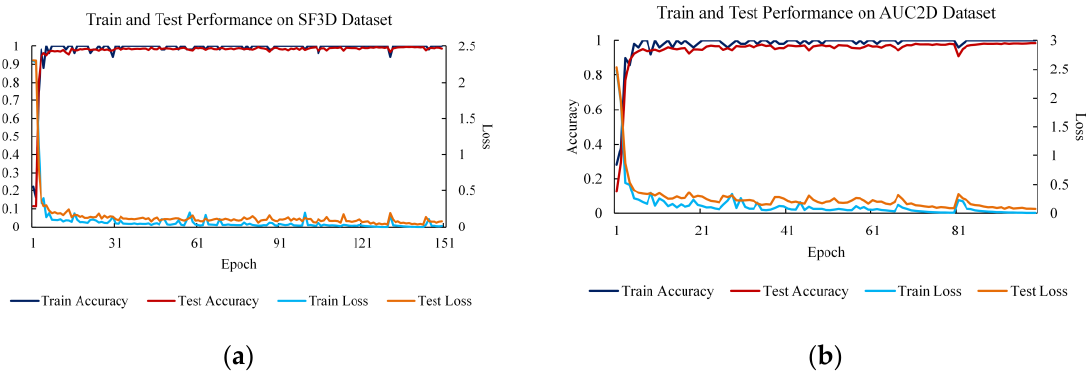
Figure 9. Training and testing performance. ( a ) On the SF3D dataset. ( b ) On the AUC2D dataset.